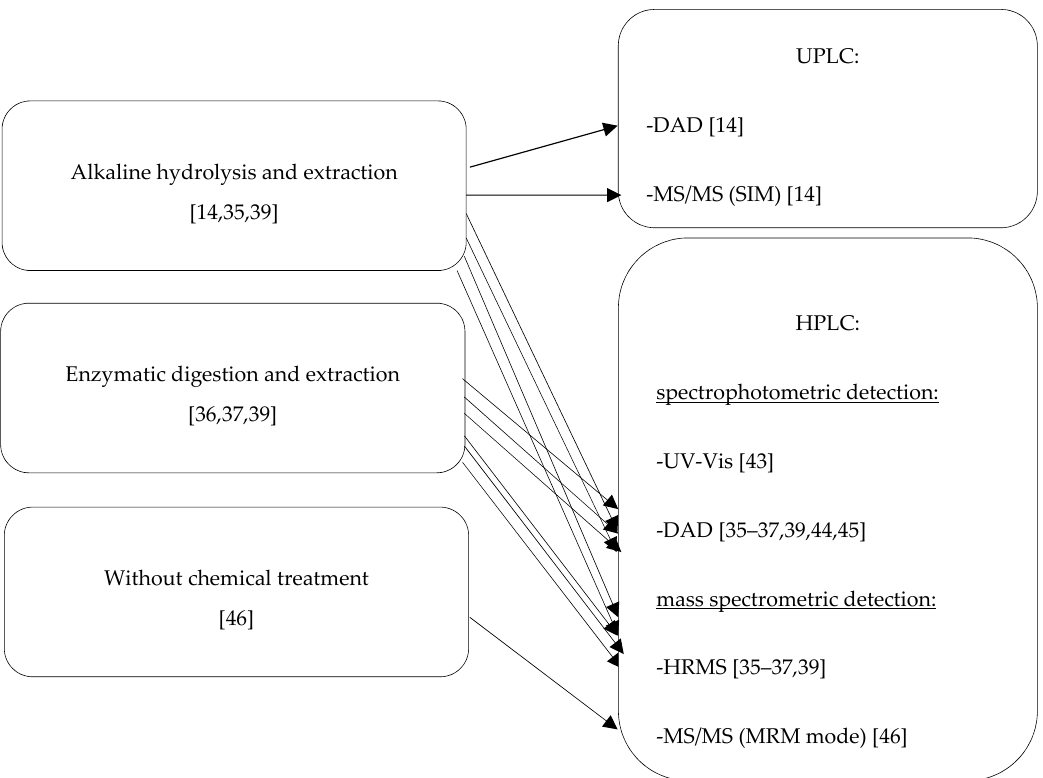
Figure 9. Chromatographic methods applied for the identification of extracted reactive dyes for forensic purposes.